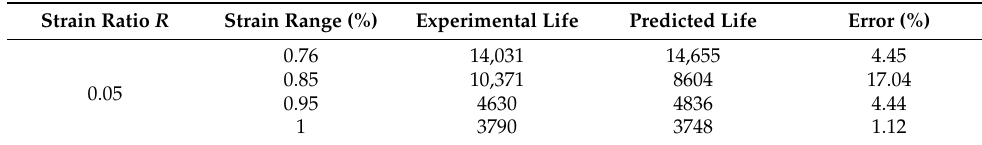
( b ) Figure 9. Life prediction of non-destructive specimens with R = 0.2: ( a ) Fatigue life prediction curve ( b ) Fatigue life pre- diction error.